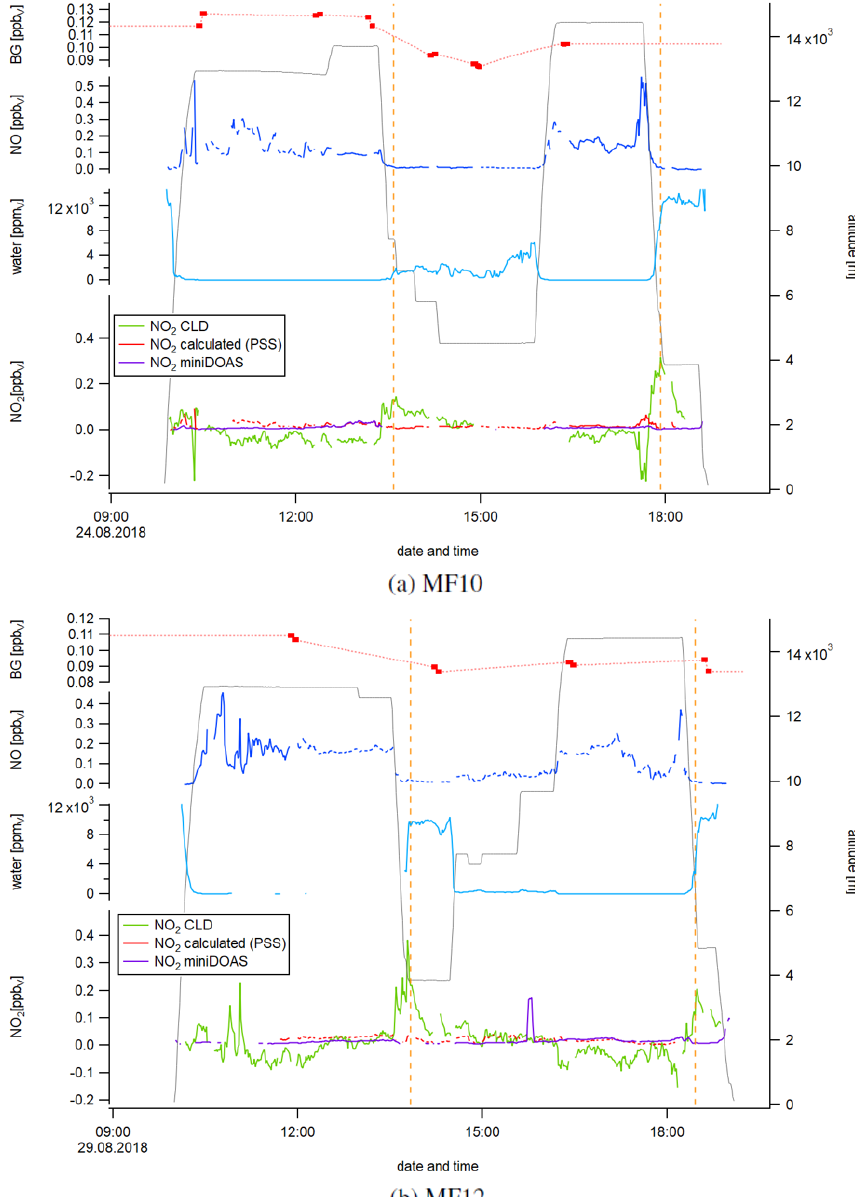
Figure 5. Temporal development of the instrumental background (BG) in the NO c channel, NO, water vapor, and calculated and measured NO 2 for measurement flights 10 and 12. The orange dashed lines indicate the simultaneous occurrence of a rapid decrease in altitude, an increase in water vapor concentration and a peak in the NO 2 CLD